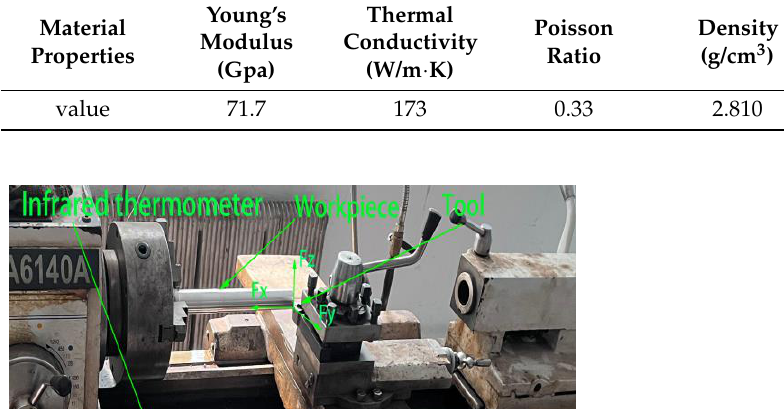
Table 2. 7075AL aluminum alloy material performance parameters [22].